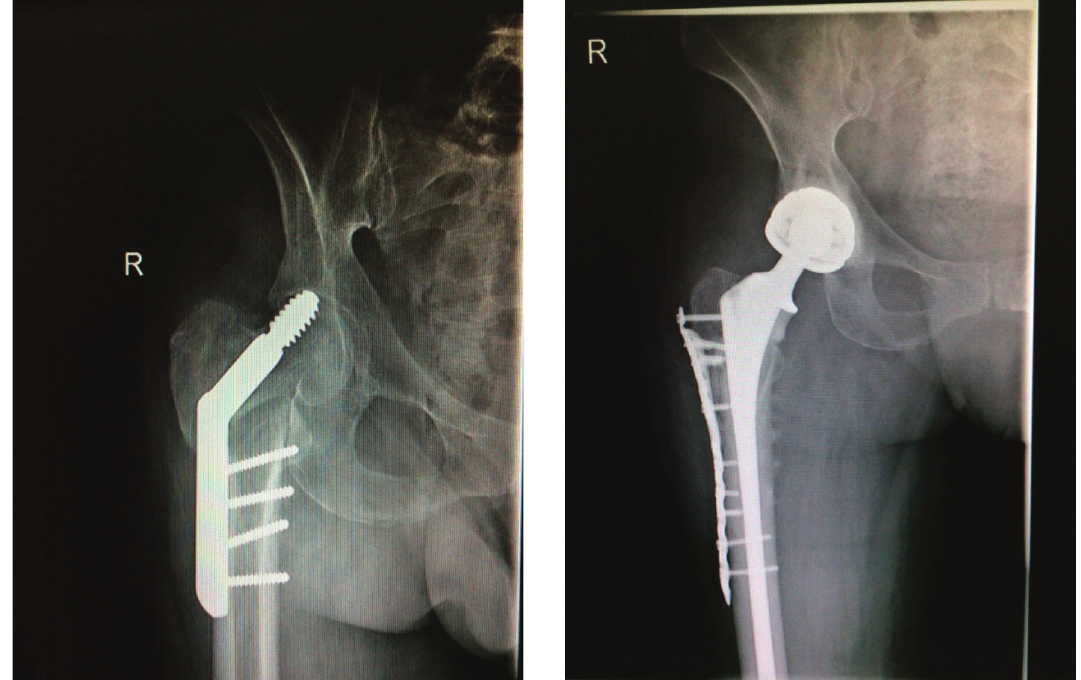
Figure 1. Radiograph of patient with failed DHS revised to dual mobility THR. Locking plate used to stabilize the trochanteric